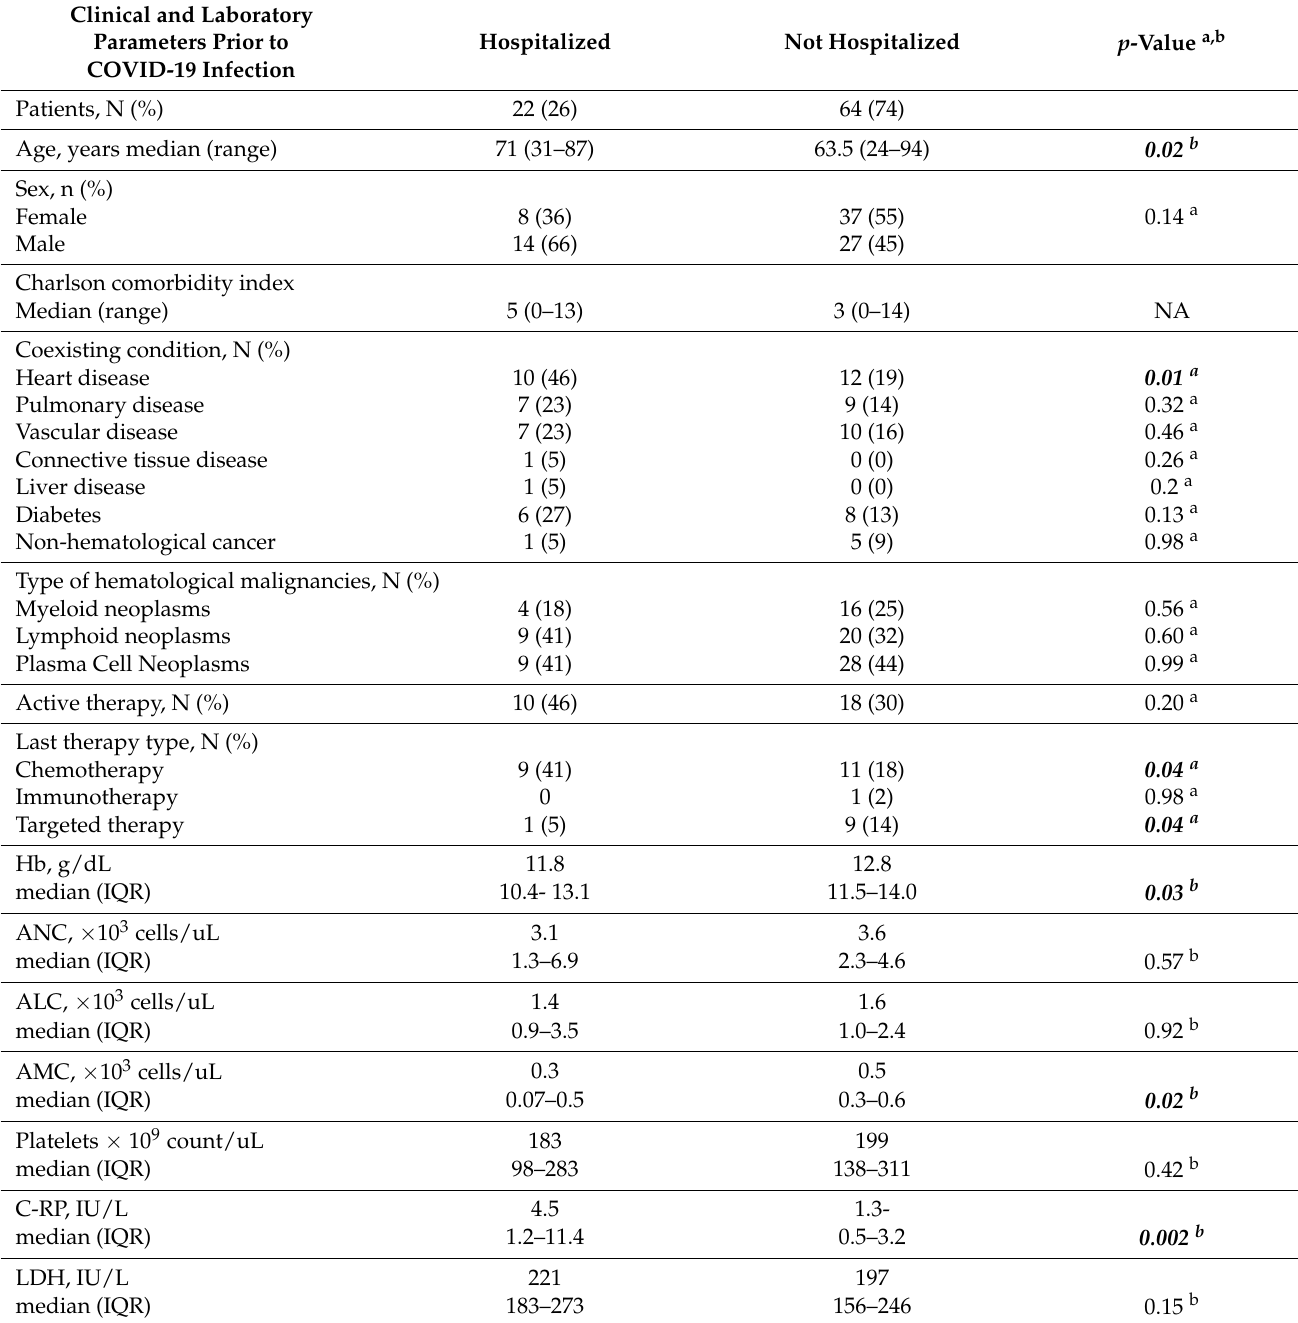
Table 3. Pre-infection clinical and laboratory parameters in hematological patients hospitalized or not hospitalized for concomitant